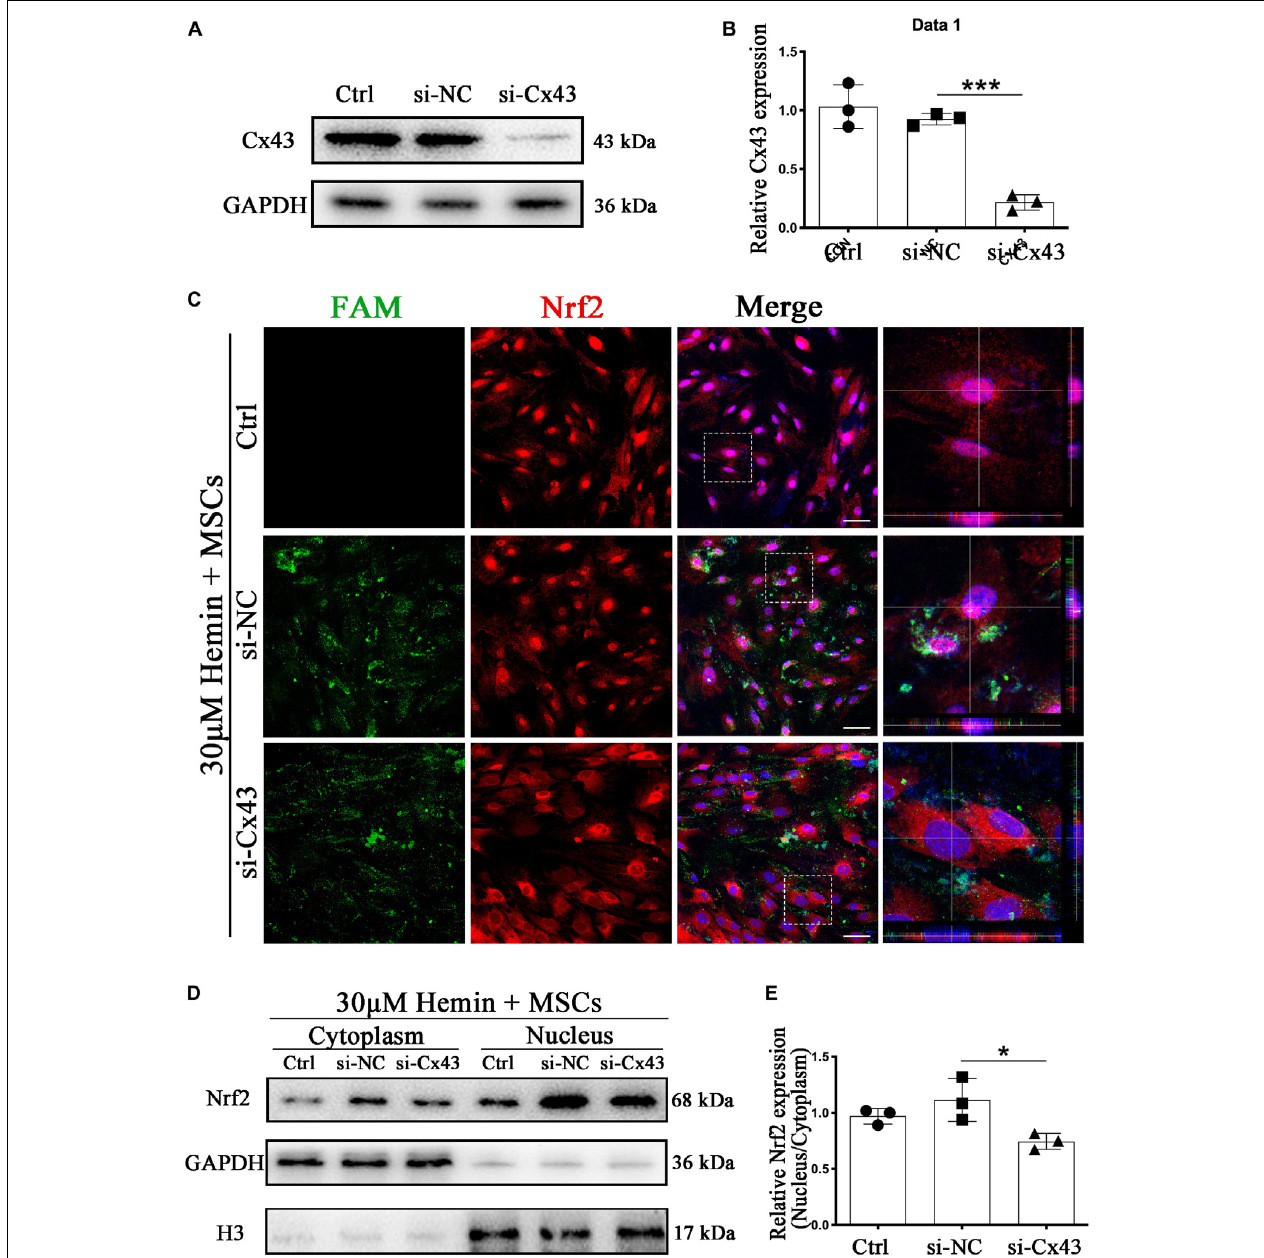
FIGURE 7 | Cx43 knockdown suppressed BM-MSCs-induced Nrf2 nuclear translocation. (A,B) Western blotting analysis of Nrf2 expression in control, si-NC, si-Nrf2 transfected astrocytes. (C) Immunofluorescence staining of control, si-NC, si-Cx43 treated astrocytes with anti-Nrf2 (red). The siRNA was labeled with fluorophore FAM (green) to show the transfected cells. The cell nuclei were counterstained with DAPI (blue). Bar = 50 µ m. (D) Western blotting analysis of cytoplasmic and nucleus extraction samples from control, si-NC, si-Cx43 transfected astrocytes with anti-Nrf2. GAPDH and H3 were used as a loading control for cytoplasmic and nucleus protein, respectively. (E) The histogram showing the results of densitometric analysis of nucleus/cytoplasmic Nrf2 expression in control, si-NC, si-Cx43 transfected astrocytes. All data are displayed as means ± SD ( n = 3). The difference between groups was analyzed using One-way ANOVA test. * p < 0.05, *** p <